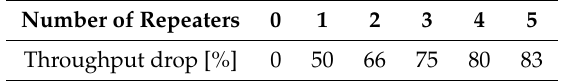
Table 2. Theoretical throughput drop based on the results of our